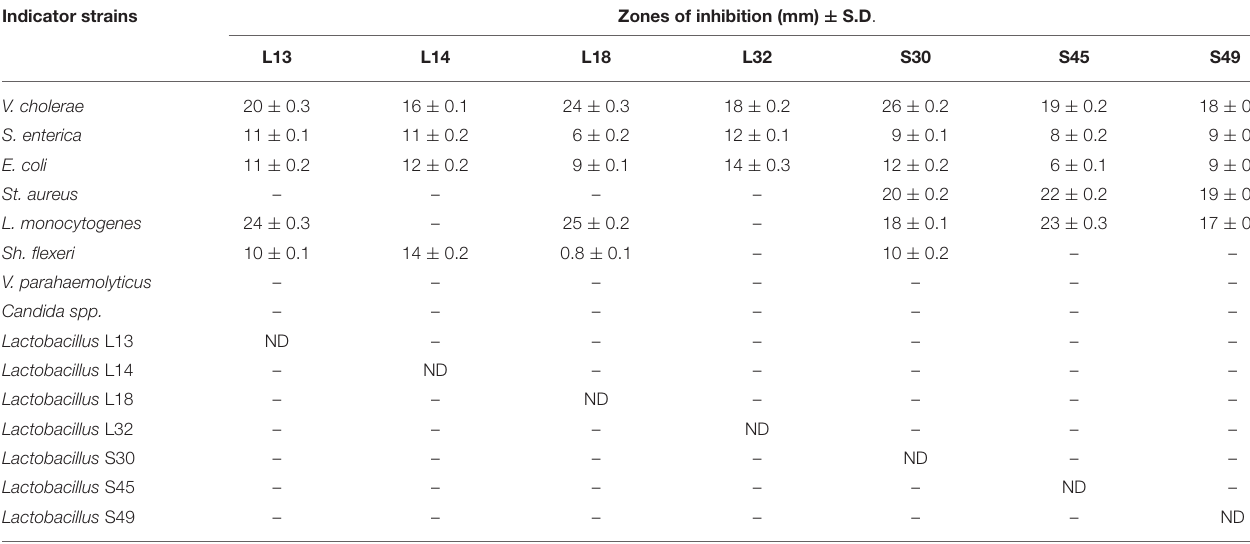
TABLE 2 | The antagonistic activities of the cell-free culture supernatants of fecal lactobacilli against various pathogenic and commensal indicator strains. Indicator strains Zones of inhibition (mm) ± S.D